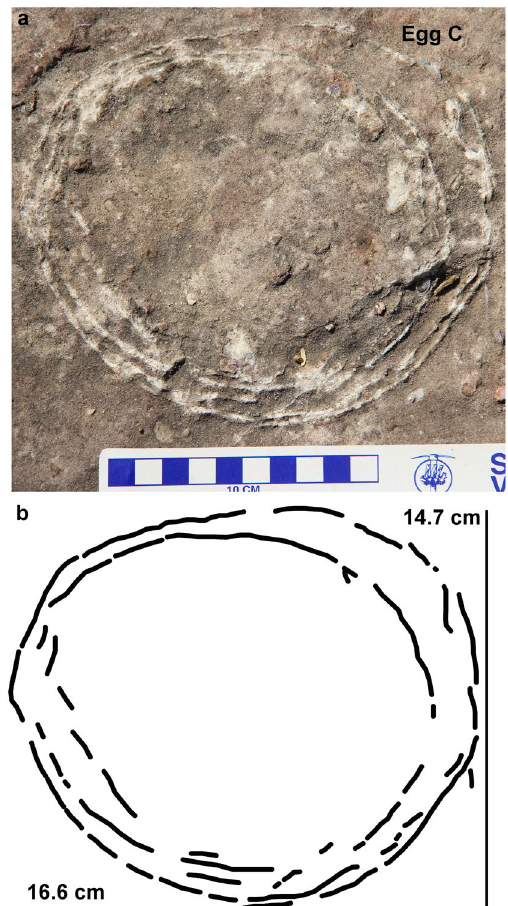
Figure 11. Field photograph and schematic diagram of the pathologic ovum-in-ovo egg (egg number C) documented from the Lameta Formation of village Padlya, Dhar District, M.P., India. Two slightly partially broken circular eggshell outlines can be seen with broken eggshell fragments within. A crescent-shaped gap is characteristically present in the upper right part of the egg ( b drawn using software Adobe Photoshop